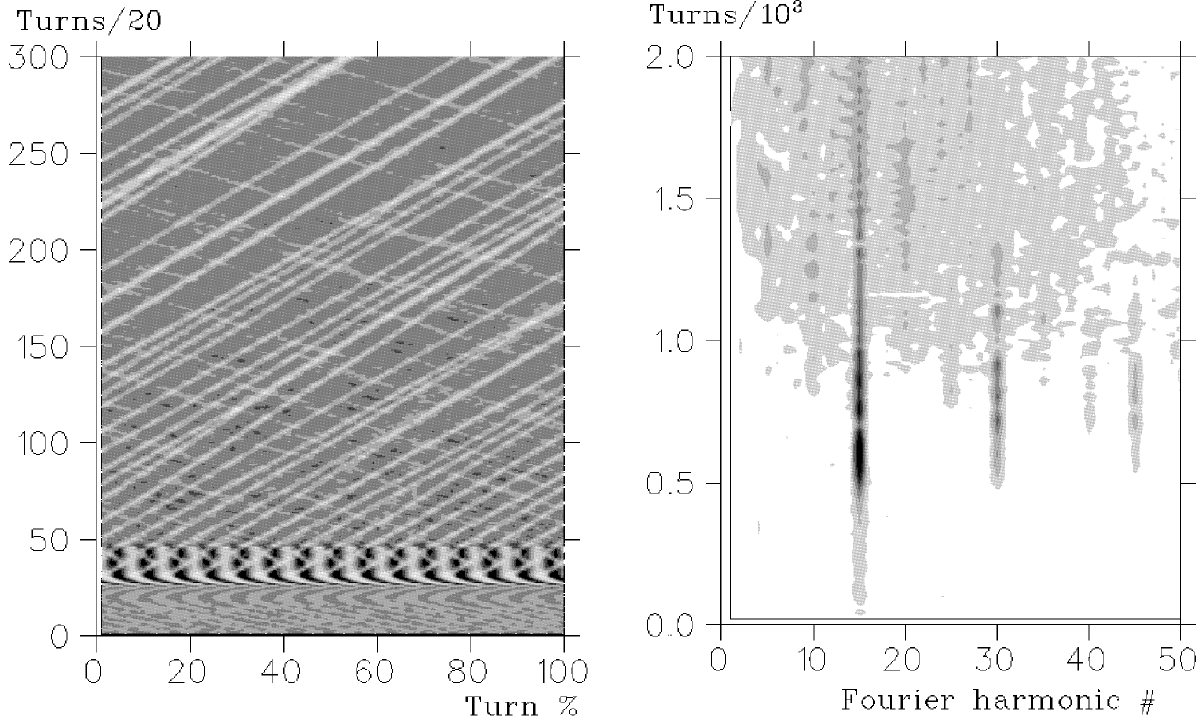
FIG. 19. Waterfall plots of line density (left) and Fourier content (right) for 6000 and 2000 turns, respectively. 4 3 10 12 protons, 10 6